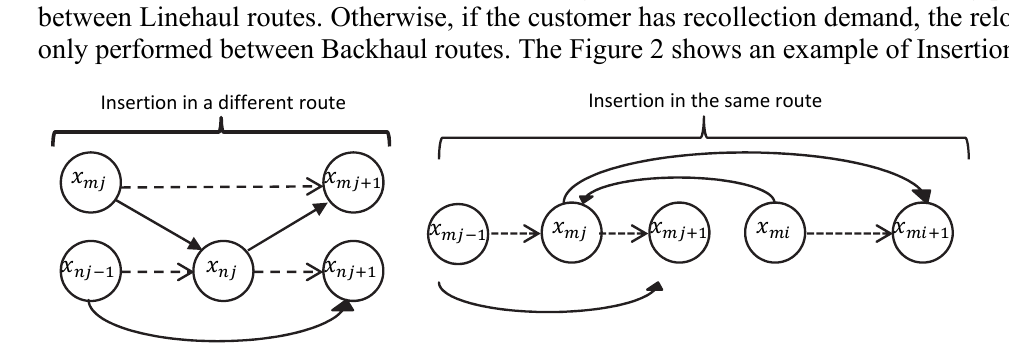
Fig. 2. Examples of Insertion moves on Linehaul routes